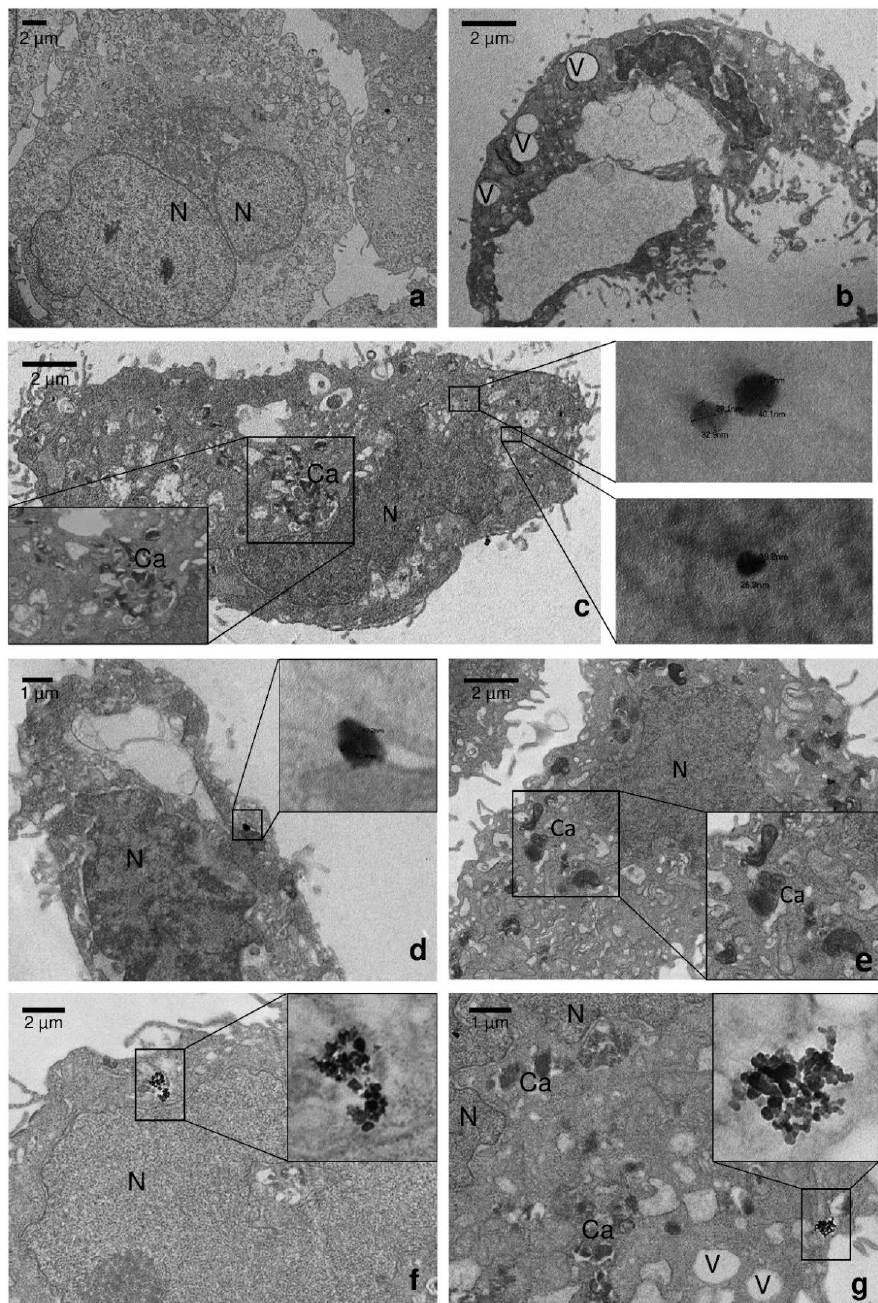
Figure 5. TEM ultrastructural analysis of ultrathin sections of ( a ) untreated cells and cells exposed for 24 h to 1000 µg/mL of: ( b ) bulk fosetyl-Al; ( c ) nanoFos; ( d ) CH-nanoFos; and 100 µg/mL of: ( e ) bulk fosetyl-Al; ( f ) nanoFos; ( g ) CH-nanoFos. N = nuclei; V = vacuoles; Ca = calcifications. fosetyl-Al; ( f ) nanoFos; ( g ) CH-nanoFos. N = nuclei; V = vacuoles; Ca =